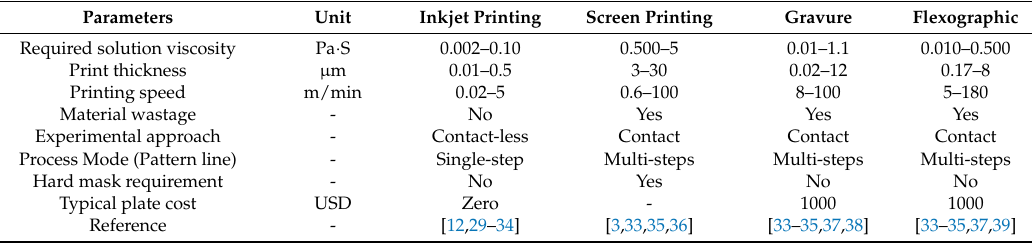
Table 1. Comparison of inkjet printing with screen, Gravure and Flexographic printing.